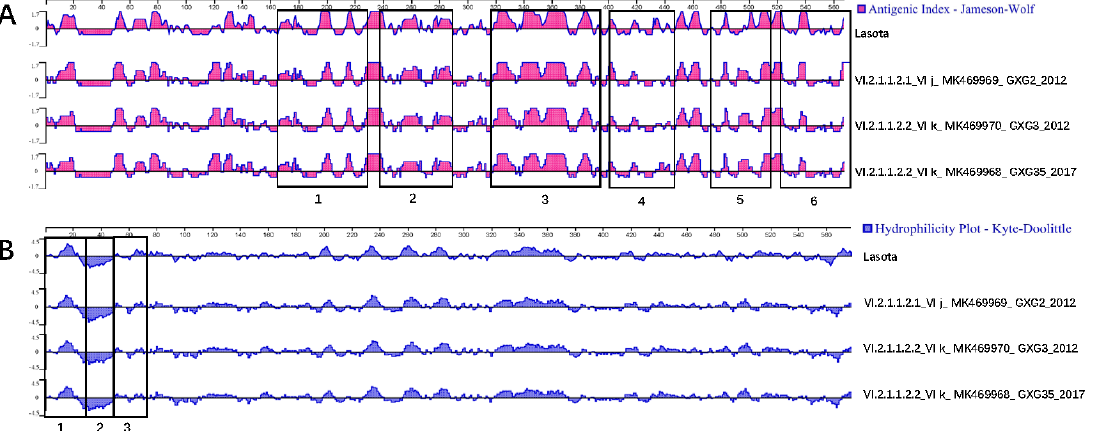
Figure 3. Comparison of the antigenicity and hydrophilicity of the HN of selected PPMV-1 and LaSota vaccine. Protean module of Laser gene was used to describe and analyze the antigenicity and hydrophilicity of hemagglutinin-neuraminidase (HN). GXG3 and GXG35 are representative isolates of sub-genotype VI.2.1.1.2.2, GXG2 is a representative isolate of sub-genotype VI.2.1.1.2.1, and LaSota vaccine is representative of genotype II vaccines. The pink diagram represents the antigenicity analysis of the HN, and the blue diagram represents the hydrophilicity analysis of the HN. The rectangular areas highlight the antigenicity and hydrophilicity di ff erences in the HN between di ff erent viruses. ( A ) 1. HN helical folding structures: region 1 (175–228 aa); region 2 (237–288 aa); region 3 (316–396 aa); region 4 (401–443 aa); region 5 (472–515 aa); and region 6 (521–577 aa); ( B ) signal peptide region in cytoplasm (tail, 1–26 aa); 2. transmembrane region (rod-shaped, 27–48aa); 3. extracellular amino acids region (spherical head,